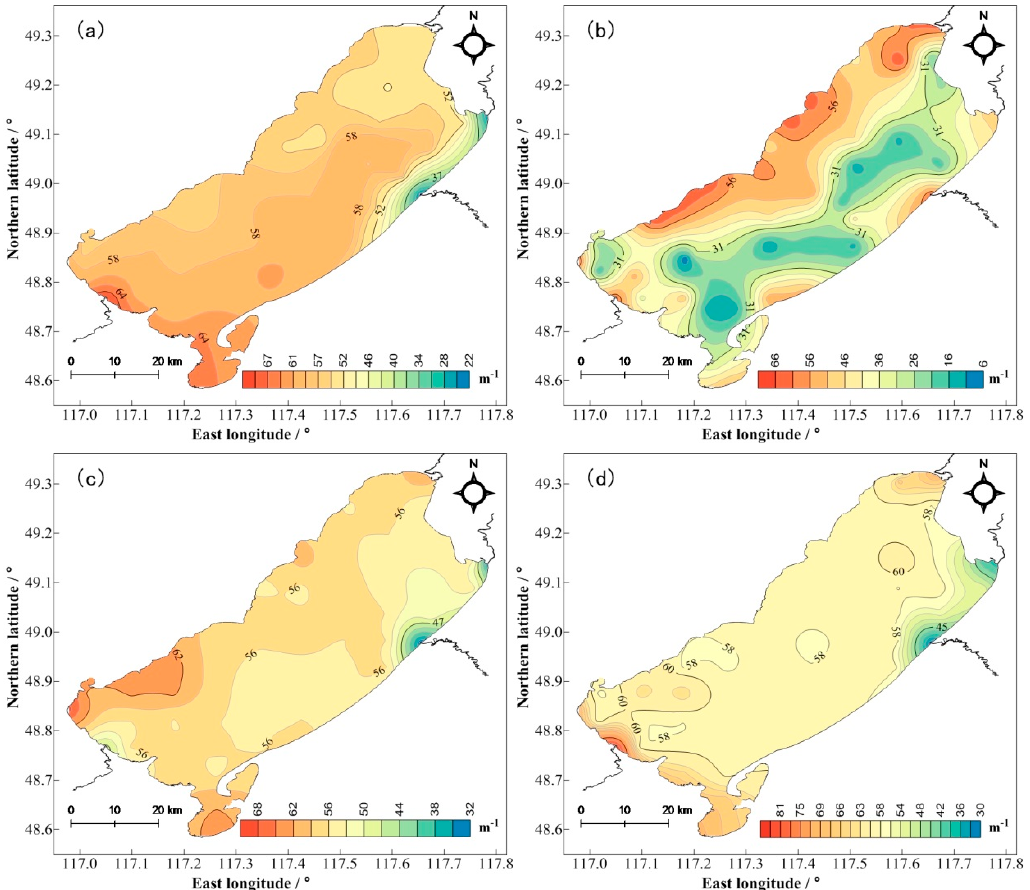
Figure 3. Spatial distributions of chromophoric DOM (CDOM) concentrations ( α 254 , m − 1 ) in ( a ) autumn: October 2018, ( b ) winter: March 2019, ( c ) spring: May 2019, and ( d ) summer: July2019.